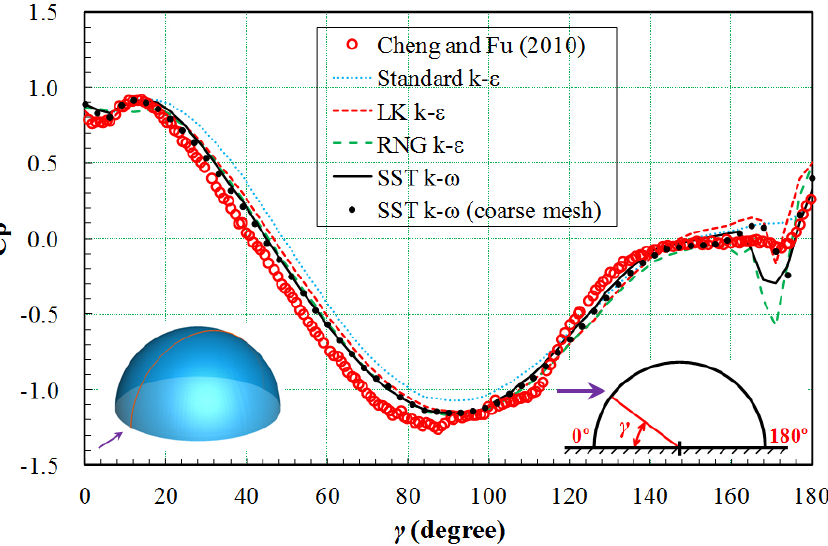
Figure 1. Comparisons of mean pressure coefficient Cp along the centre meridian of the hemisphere under a smooth inflow condition.